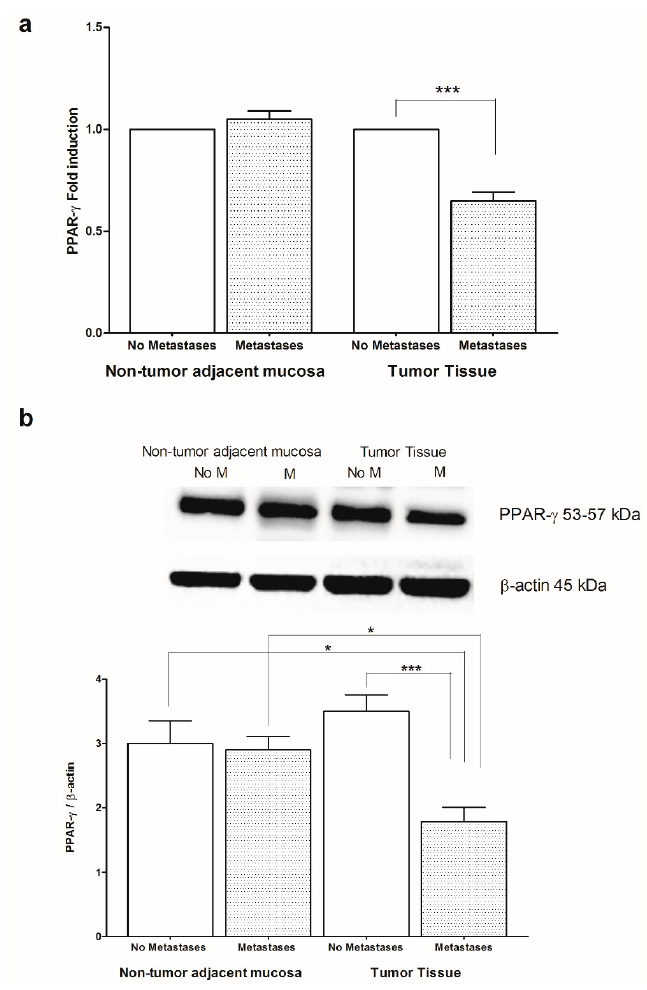
Figure 4. ( a ) Peroxisome proliferator-activated receptor gamma (PPAR- γ ) mRNA levels in non-tumor adjacent mucosa and tumor tissue from colorectal cancer patients with and without metastases. Data are expressed as Fold induction. *** p < 0.005 (Student’s t -test). ( b ) Western blotting analysis of PPAR- γ protein in the same patients. Representative blots are also shown (No M = No Metastases; M = Metastases). * p < 0.05, *** p < 0.005 (ANOVA and Tukey’s multiple comparison test).